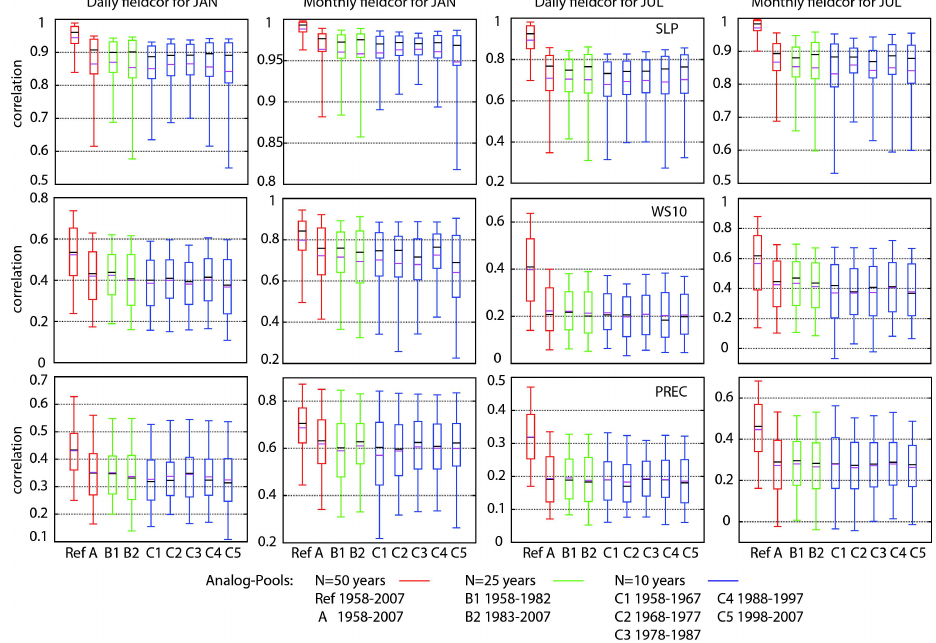
Fig. 3. Whisker-Box-Plots showing the field correlations of different test cases based on reconstructions from analog-pools of different size and periods. The box indicates the range of local correlations between the first and third quartile representing 50% of the local correlations around the median (black horizontal line). The pink line represents the mean of field correlation. The whiskers indicate the spread of the correlations containing 90% around the median. The reference case (Ref) is based on using model SLP as pseudo-predictor. The same stations are used for HIRESAFF (case A) but with real SLP. B1 and B2 use only 25 yr, C1–C5 only 10 yr from different periods, respectively.